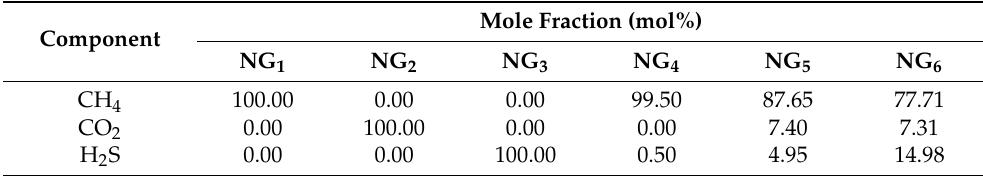
Table 3. Mole fraction of natural gas in different systems.